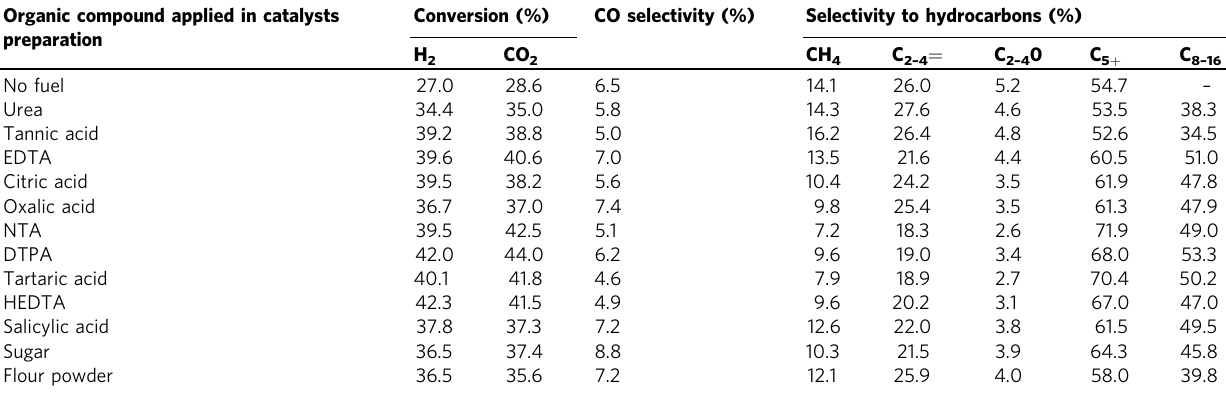
Organic compound applied in catalysts